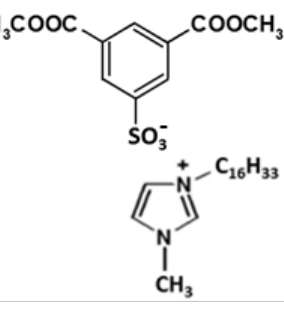
Scheme 1. Ionic liquid chemical structure.